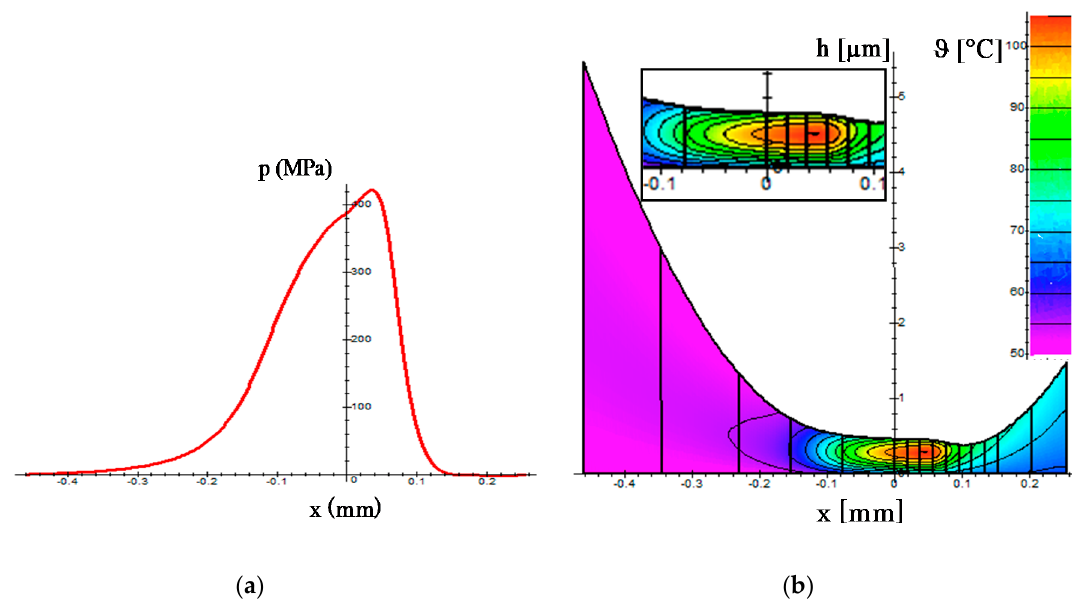
Figure 5. ( a ) Pressure distribution in the case of rolling-sliding contact S = 1.9. ( b ) Temperature distribution in the case of rolling-sliding contact S = 1.9.